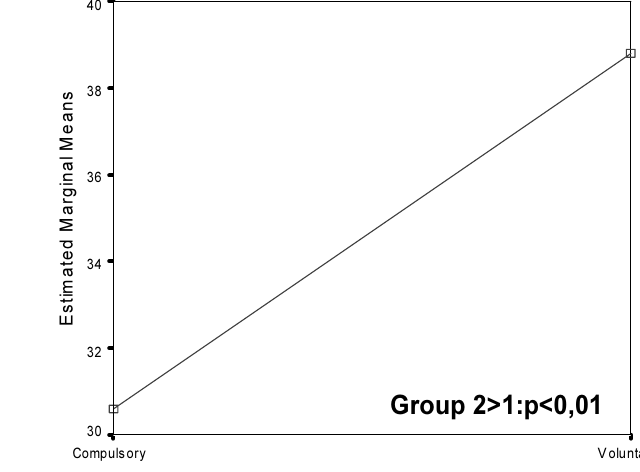
Figure 1: Scree plot of factors Figure 2: Nature of retrenchment